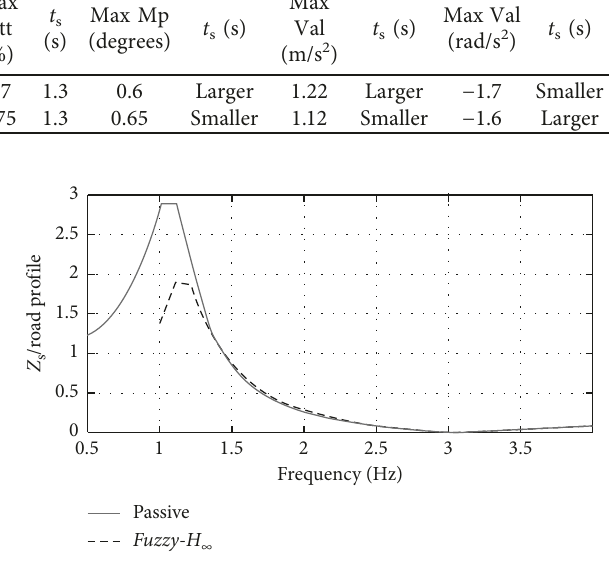
Figure 17: Ratio between chassis displacement and road disturbance.